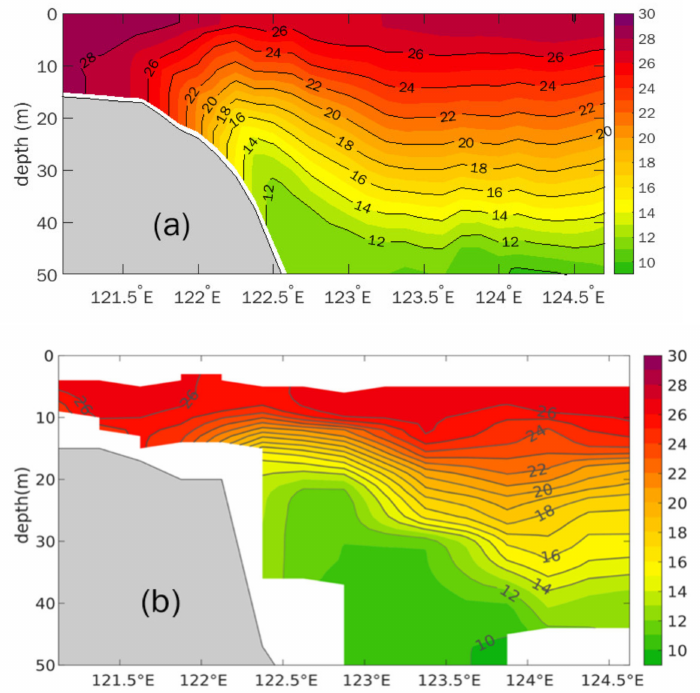
Figure 3. Vertical distributions of temperature along 34.12 ◦ N section in early August 2019 for ( a ) Exp.C and ( b ) observations (unit: ◦